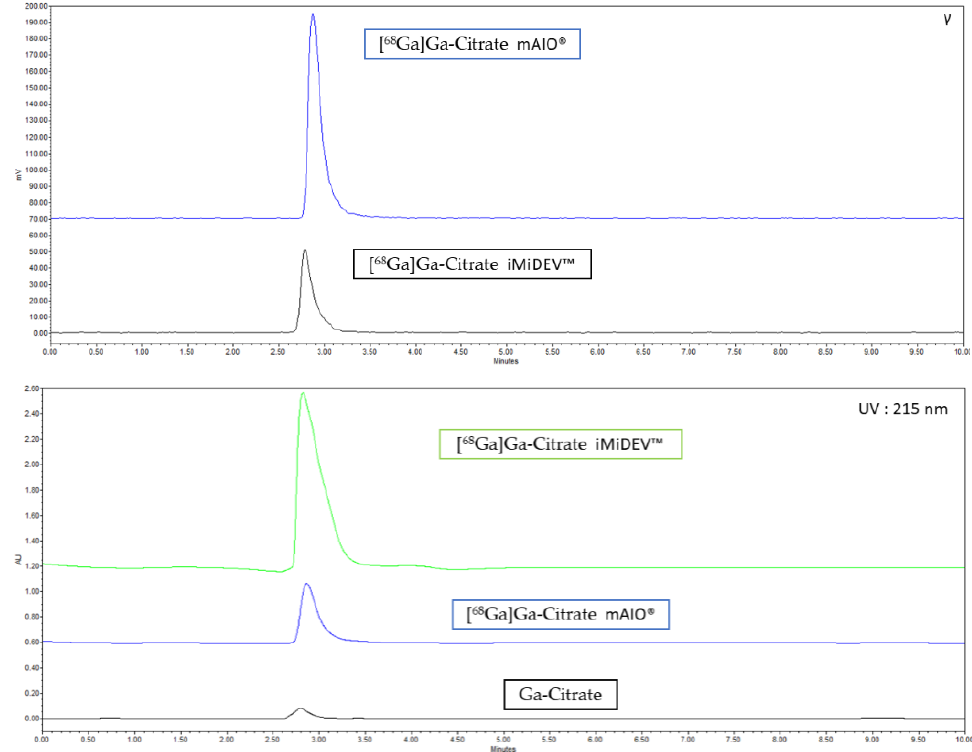
Figure 5. HPLC chromatograms of [ 68 Ga]Ga-citrate production. ( Top ) radioactive detection; ( Bottom ) UV 215 nm detection. Table 7. Results of validation of [ 68 Ga]Ga-citrate production with three consecutive